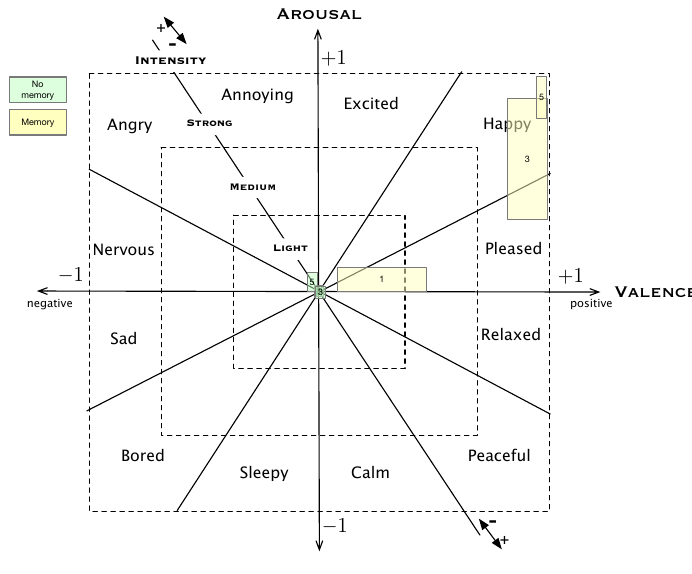
Figure 4. Experiment